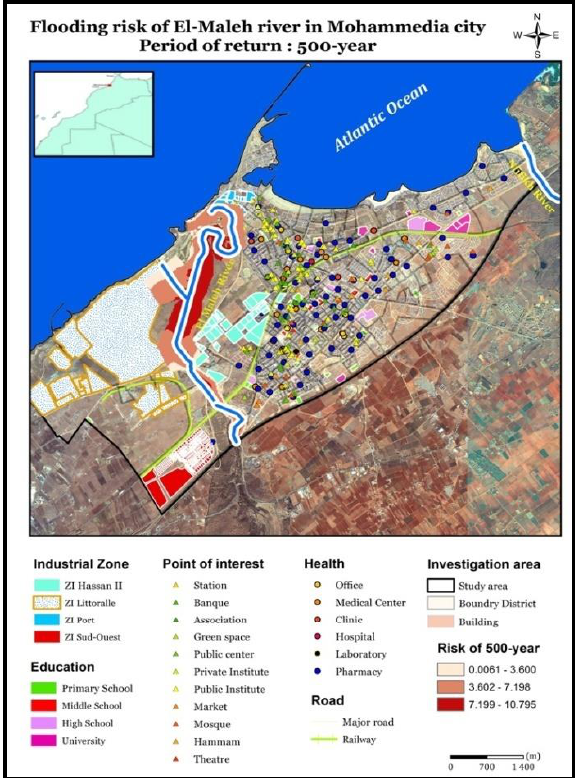
Figure 11. Flooding risk of a 500-year